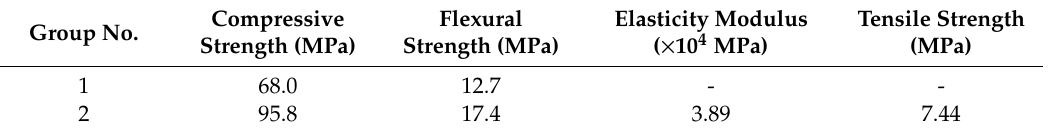
Figure 4. Stress-strain curves of steel profile and sleeve steel in the first and second test groups. Table 3. Material properties for grout [22].